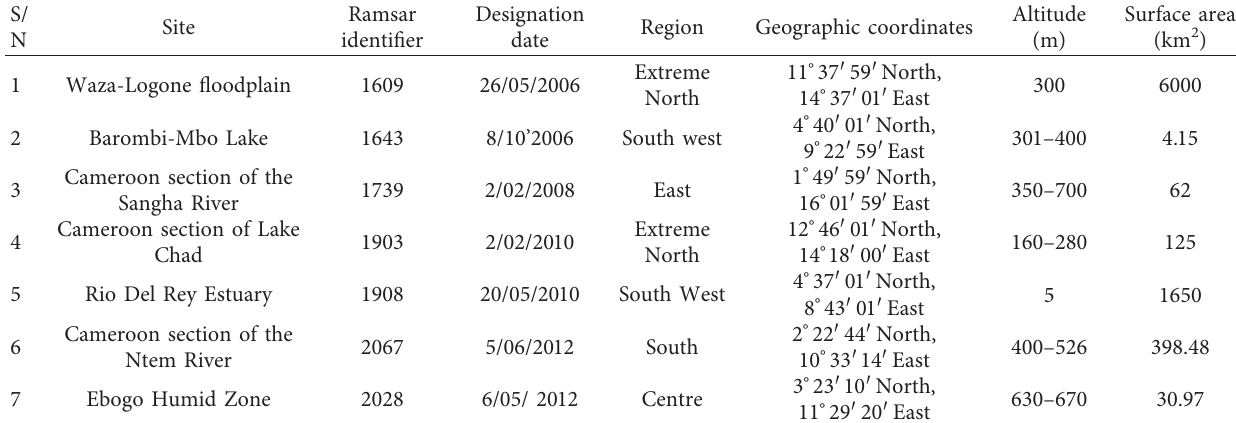
Table 9: List of Ramsar sites in Cameroon